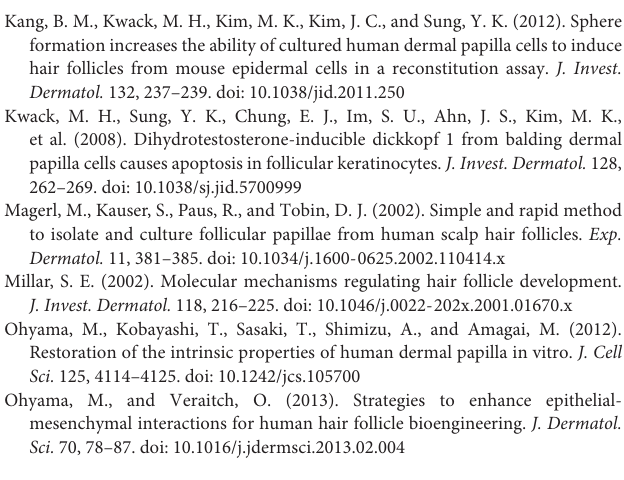
Supplementary Table 4 | Detail list of down-regulated genes related to GO biological process. Supplementary Table 5 | Detail list of up-regulated genes related to KEGG pathway. Supplementary Table 6 | Detail list of down-regulated genes related to KEGG